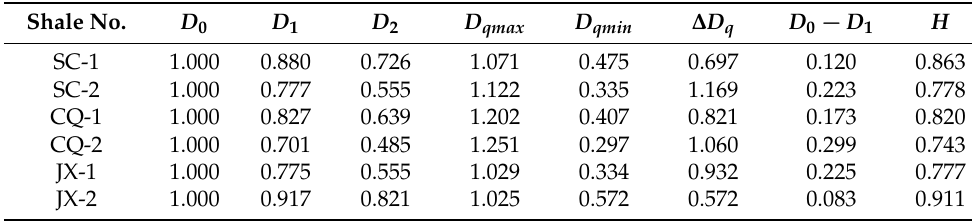
Table 3. Characteristic parameters from generalized fractal spectra of inorganic shale pores. Shale No. D